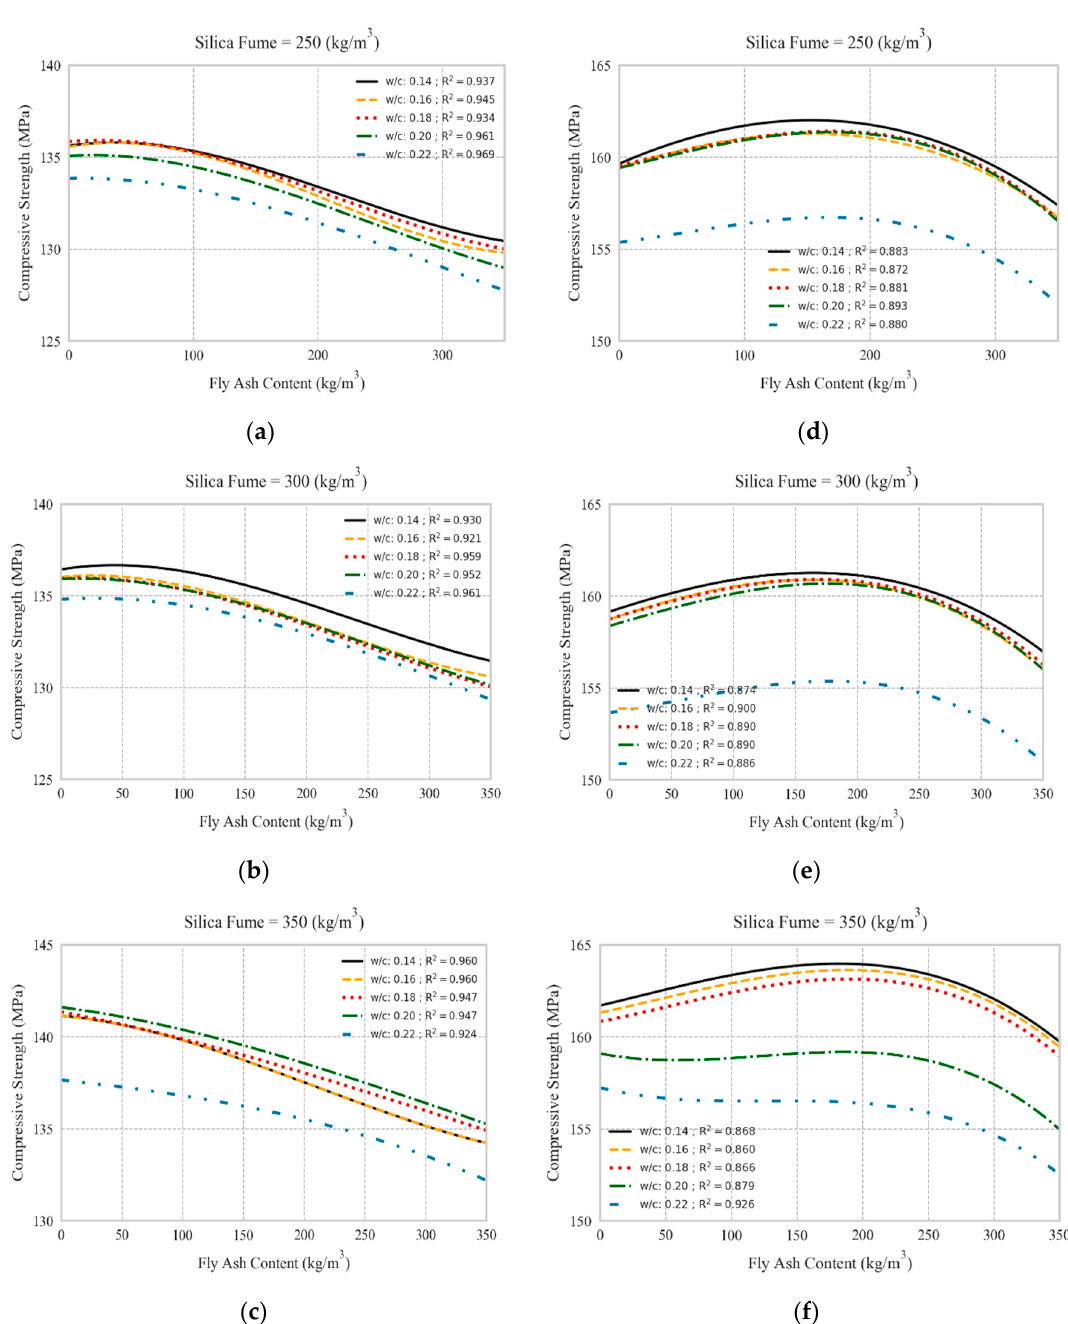
Figure 7. Effect of slag partial replacement for cement on compressive strength: ( a – c ): without steel fiber having 250, 300, and 350 kg/m 3 silica fume, respectively; ( d – f ): with 2% vol. steel fibers having 250, 300, and 350 kg/m 3 silica fume, respectively.